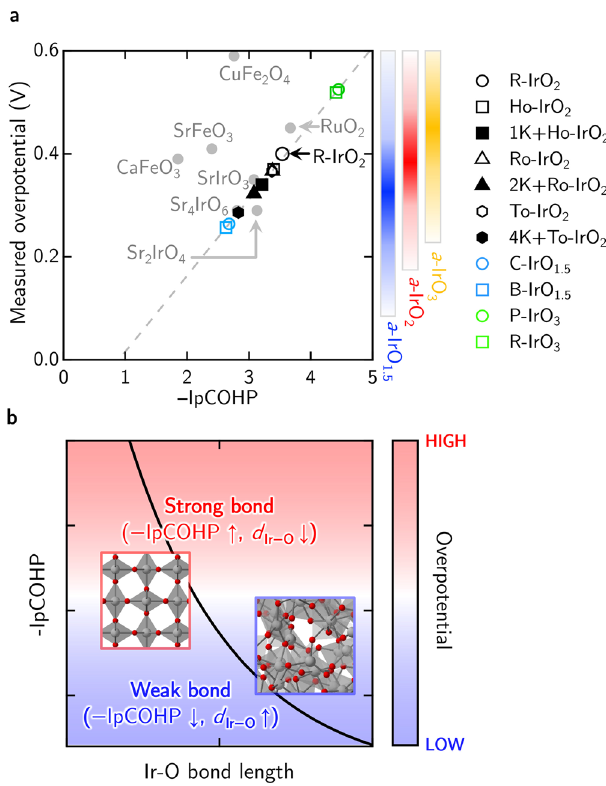
Fig. 7 Empirical regression model for structure-property relations in various OER oxide catalysts. a The experimental overpotentials of RuO 2 , SrIrO 3 , Sr 2 IrO 4 , Sr 4 IrO 6 , CuFeO 3 , SrFeO 3 , and CaFeO 3 are taken from refs. 48 – 51 . The − IpCOHP values are thus calculated from the Ir – O, Ru – O, or Fe – O bonding, accordingly. The gray dotted line is a least-square linear regression using values determined for R-IrO 2 , 1K + Ho-IrO 2 , SrIrO 3 , Sr 2 IrO 4 , and Sr 4 IrO 6 , with the corresponding R 2 value of 0.71. The range of overpotential values for the amorphous iridium oxides are provided from the linear regression model by considering the dispersion − IpCOHP plots shown in side-panel graph. b Schematic view of the empirical relationship between Ir – O bond length, − IpCOHP, and overpotential. The iridium and oxygen atoms are depicted as gray and red spheres, respectively, while the IrO 6 octahedra is shaded in